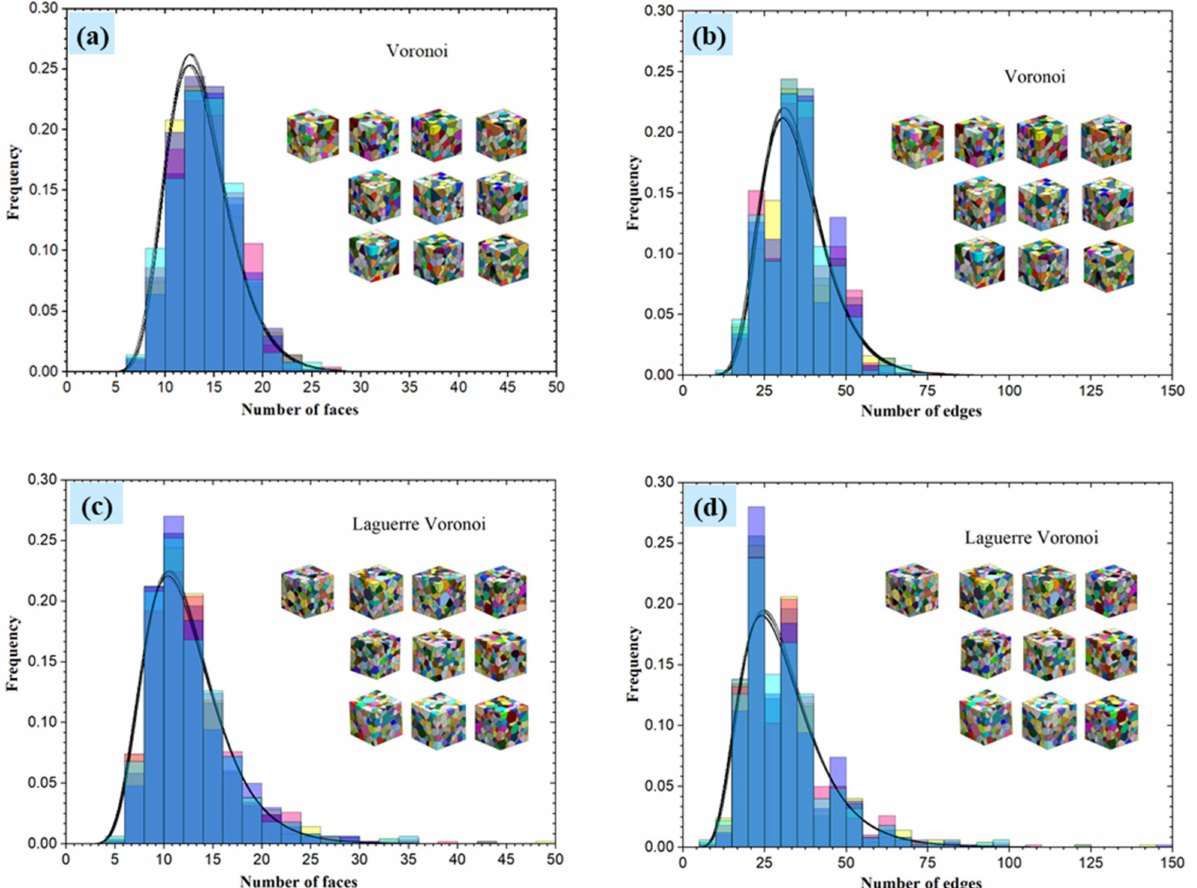
Figure 10. ( a ) Distribution of the number of grains faces, ( b ) distribution of the number of single grain edges by Voronoi tessellation, ( c ) distribution of the number of single grain faces, ( d ) distribution of the number of single grain edges by Laguerre–Voronoi tessellation.